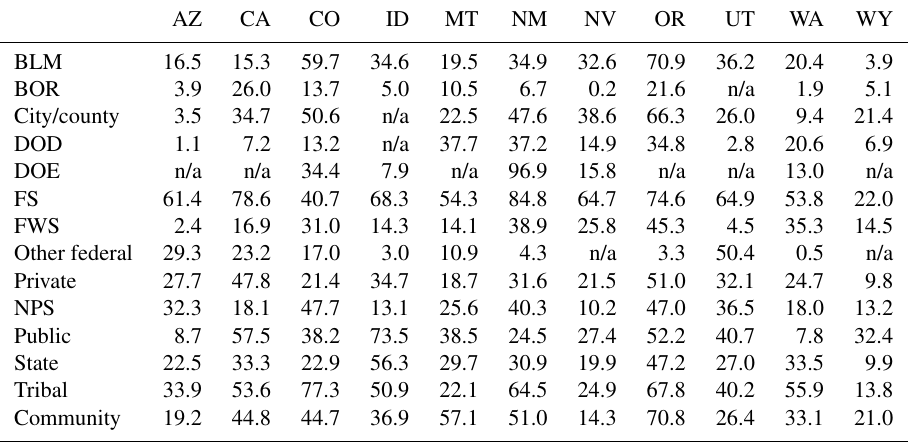
Table B1. Percentage of fire-adapted area (fire regimes 1 or 3) (source: LANDFIRE 2014) for each land tenure and state. FS: Forest Service; BLM: Bureau of Land Management; BOR: Bureau of Reclamation; NPS: National Park Service; FWS: Fish & Wildlife Service; DOD: Department of Defense; DOE: Department of Energy.